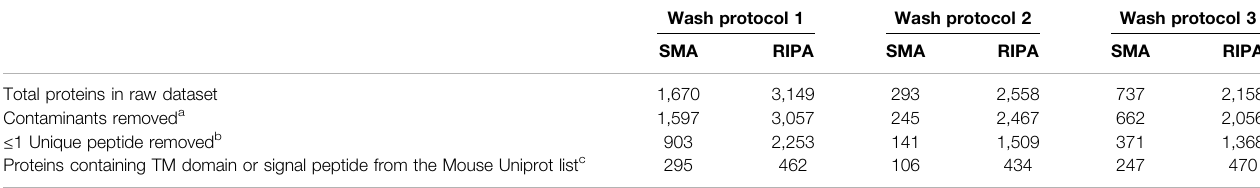
TABLE 1 | Summary of the proteins detected following different wash protocols.